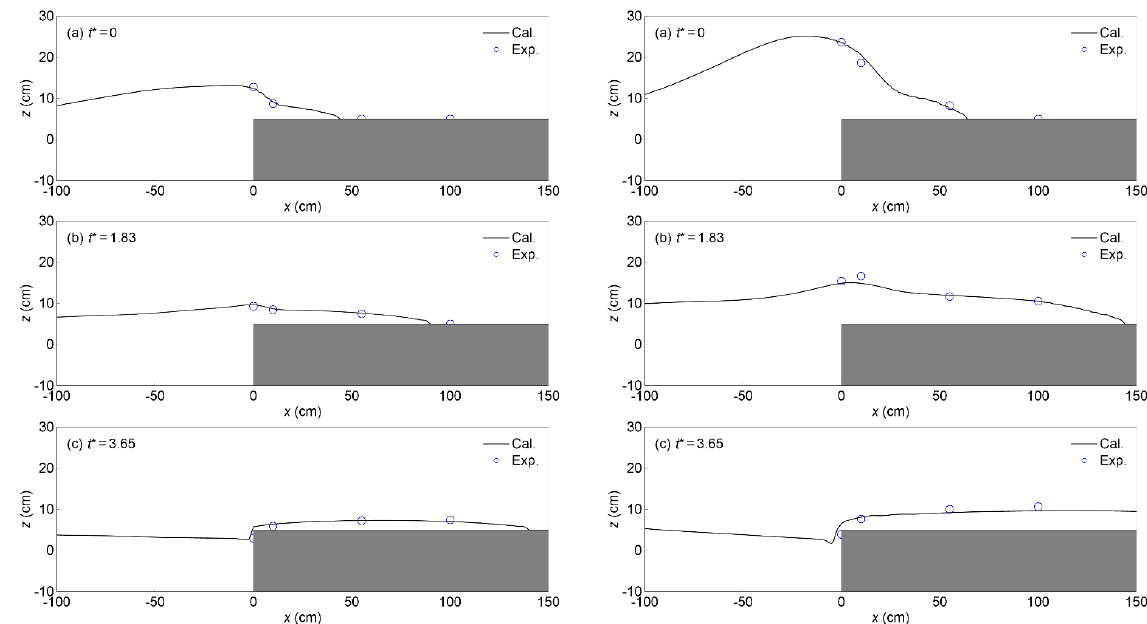
Figure 12. Spatial distributions of measured and calculated water surface elevations around the VR (left: Run-4 ( 𝐴 0 = 8.2 cm , 𝜀 = 0.18 ), right: Run-10 ( 𝐴 0 = 18.7 cm , 𝜀 = 0.4 )) — comparison between the measured and calculated results.